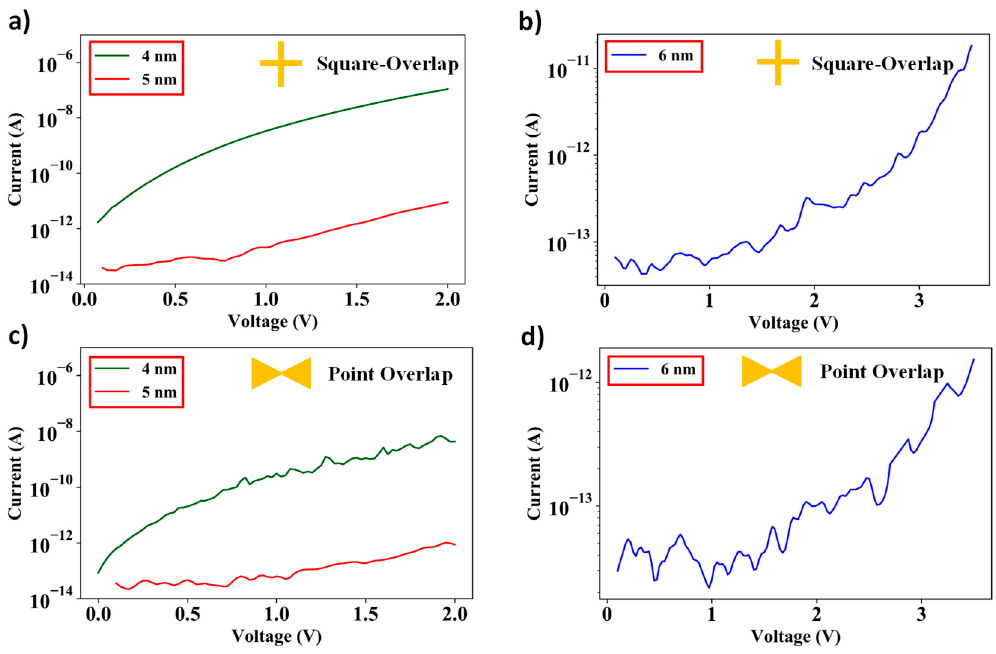
Figure 9. I–V measurements for square-overlap layout having spacer thickness of ( a ) 4 nm and 5 nm, ( b ) 6 nm, and point-overlap layout having spacer thickness of ( c ) 4 nm and 5 nm, and ( d ) 6 nm.